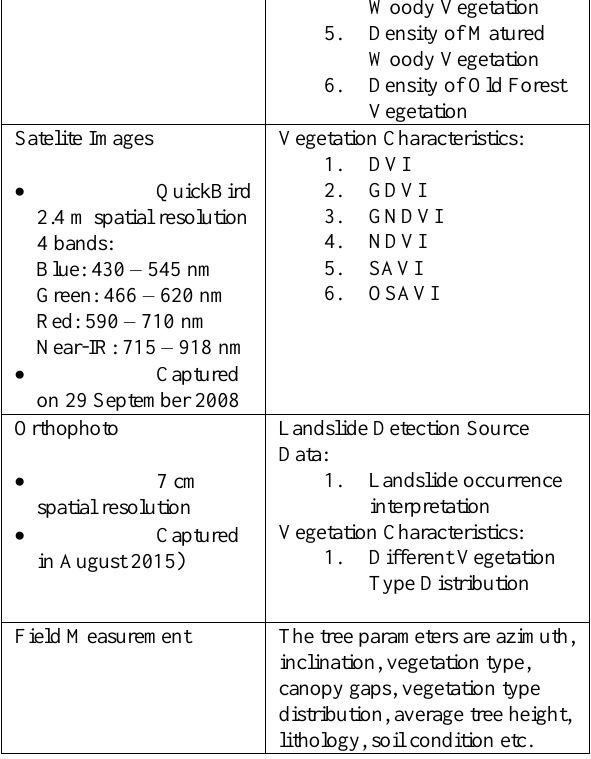
Table 1. A set of remote sensing data used in this study